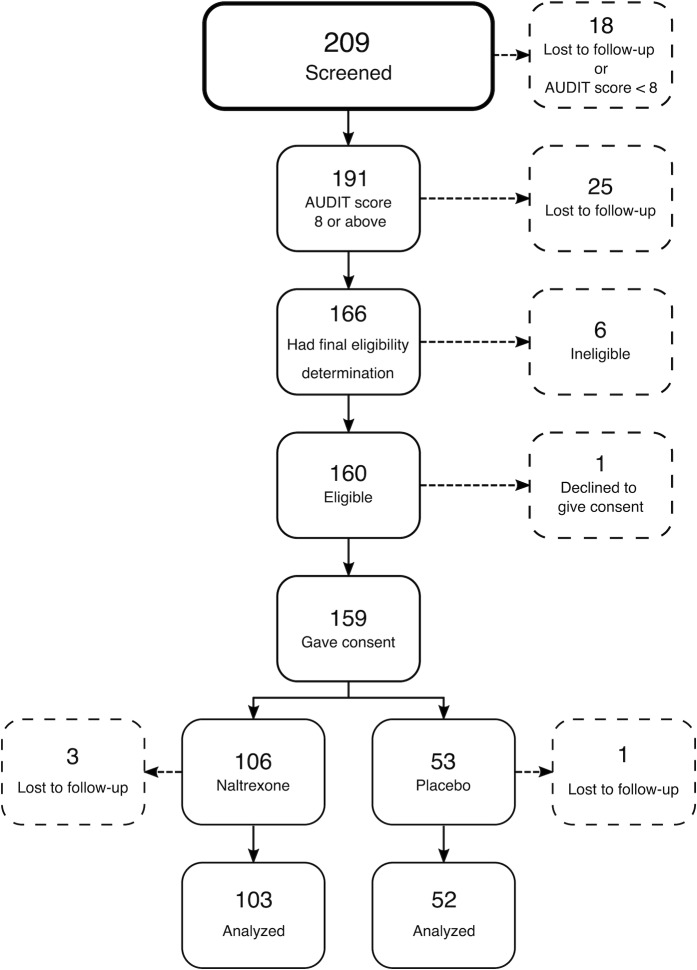
CONSORT diagram of AHORA study.